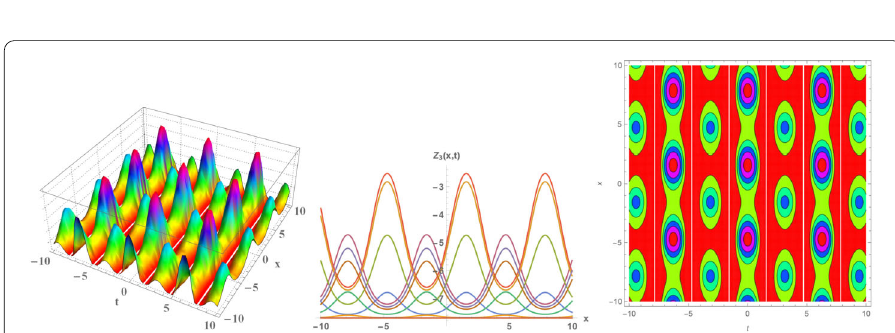
Fig. 2 shows the dark cone wave solution (14) in the three-dimensional plot (a) to explain the perspective view of the solution, the two-dimensional plot (b) to explain the wave propagation pattern of the wave along the x -axis, and the contour plot (c) to explain the overhead view of the solution when Fig. 3 shows the periodic bright cone-wave solution (40) in the three-dimensional plot (a) to explain the perspective view of the solution, the two-dimensional plot (b) to explain the wave propagation pattern of the wave along the x -axis, and